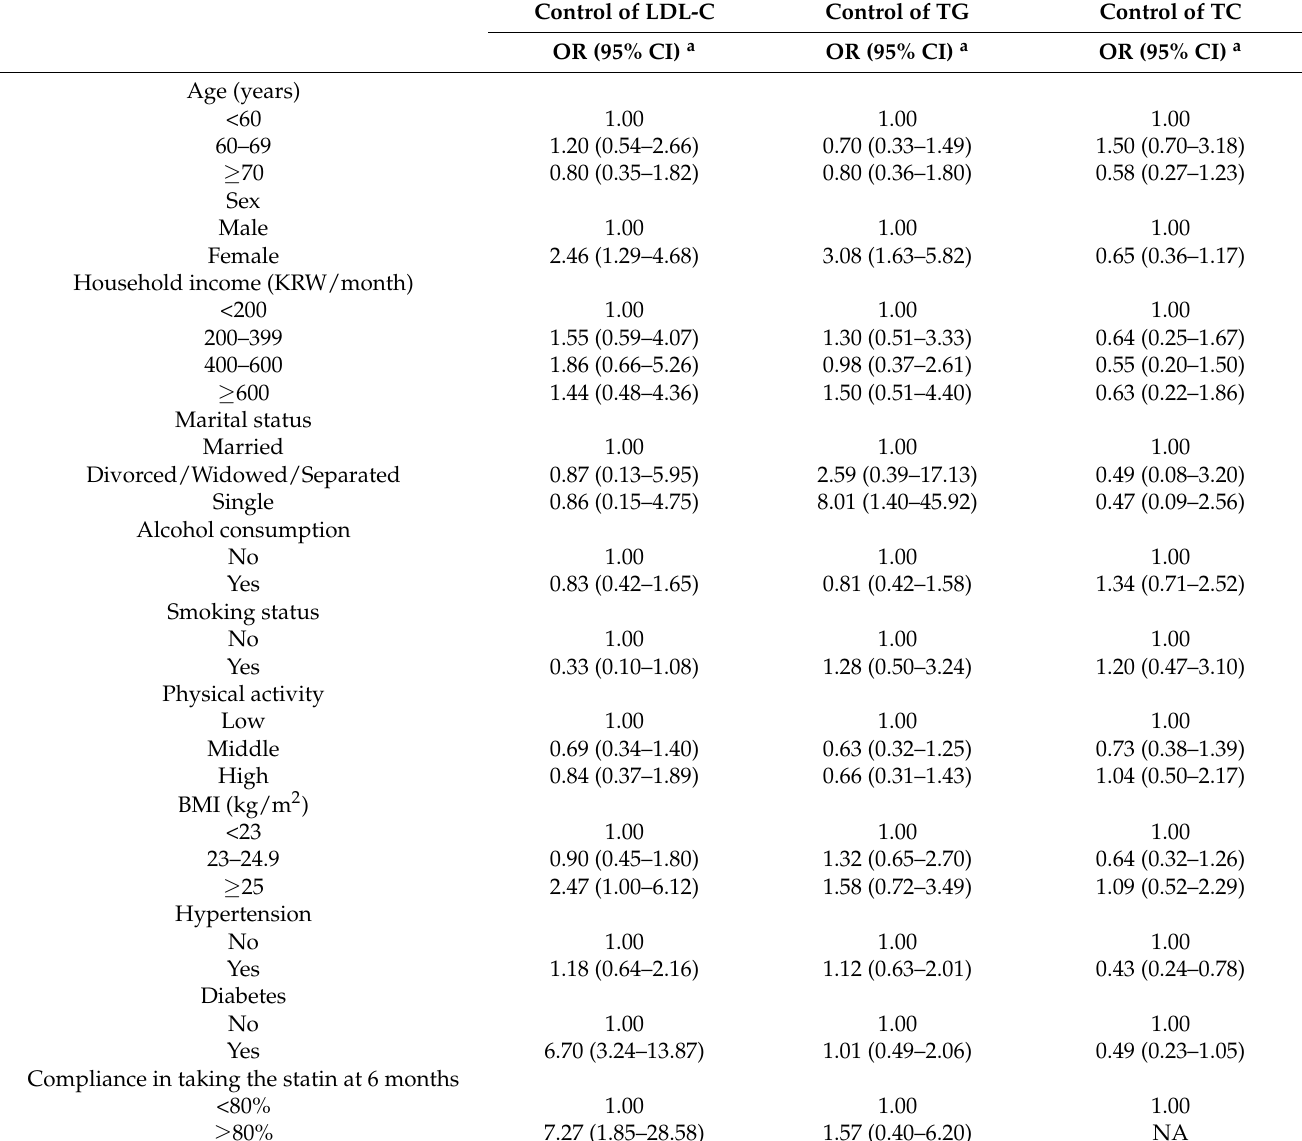
LDL-C: low-density lipoprotein cholesterol, TG: triglyceride, TC: total cholesterol, OR: odds ratio, CI: confidence interval, KRW: Korean Won, BMI: body mass index, a Adjusted for age, sex, household income, and marital